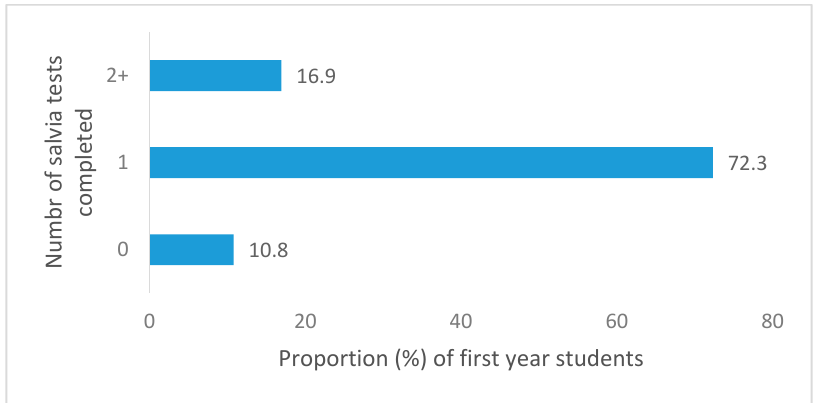
Figure 4. Reported frequency of number of PCR tests (swab and saliva) completed across 12 weeks of testing during P- ATS by total sample and stratified by first and final years.